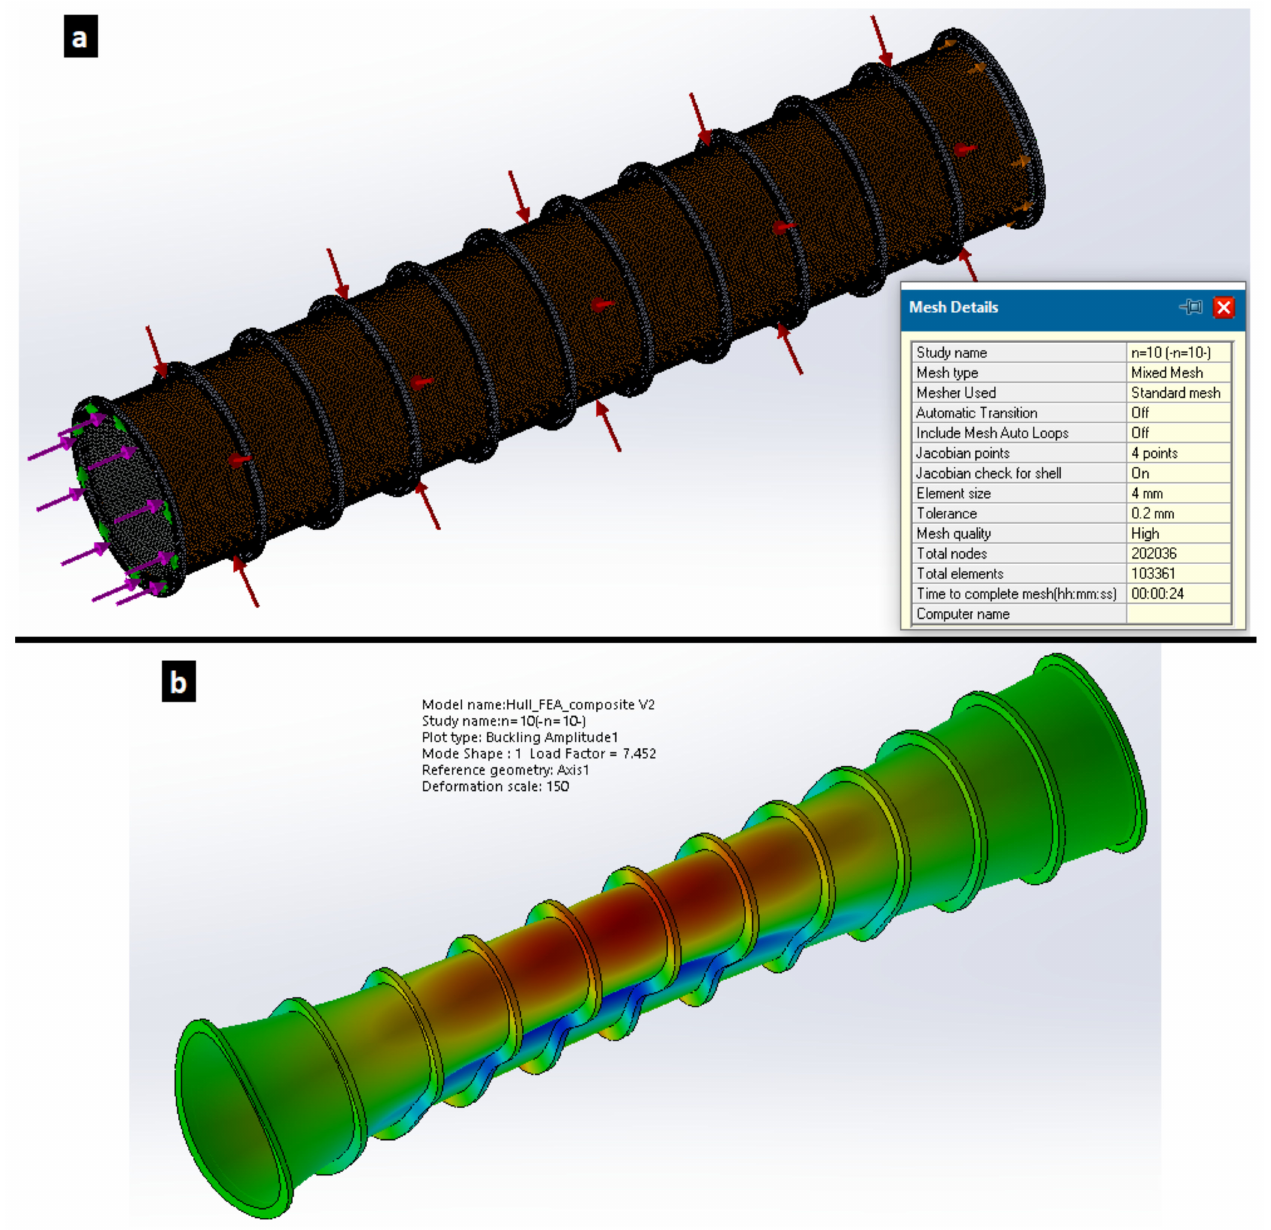
Figure 9. Stiffened cylinder–Linear buckling: ( a ) mesh and parameters; ( b ) analysis results. The nonlinear FEA analysis is presented in Figure 10: in Figure 10a, the mesh, loads, boundary conditions and mesh details are displayed; in Figure 10b, the analysis result is shown. The radial displacement diverges from linearity at t = 0.75, which translates into a pressure of 90 bar and the required FOS of 3, a much lower FOS compared to the 7.45 computed for the same configuration by the linear